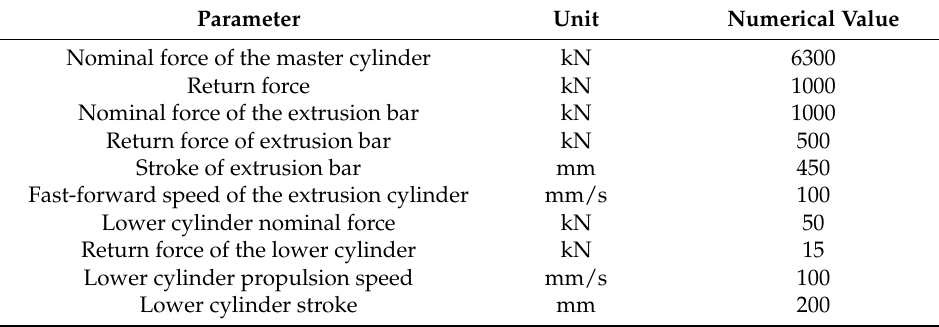
Table 3. Main technical parameters of hydraulic